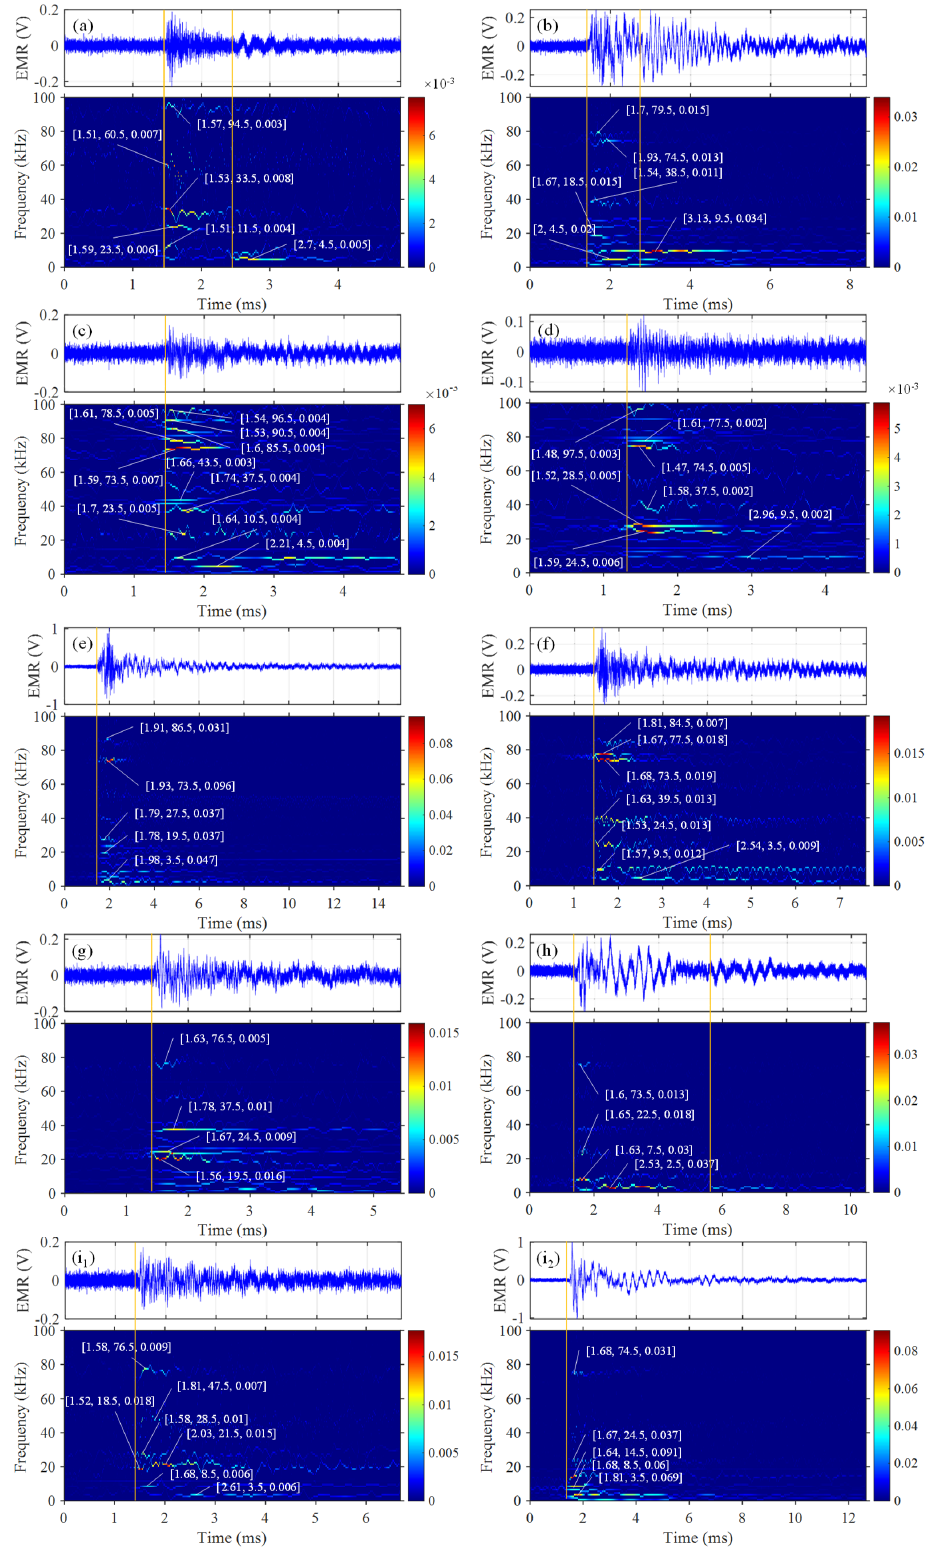
Figure 14. Time–frequency spectra of EMR waveforms obtained by EWT–HT, the arrival times of EMR waveforms, respectively, are ( a ) 496.8817 s; ( b ) 523.3260 s; ( c ) 538.9143 s; ( d ) 545.0350 s; ( e )